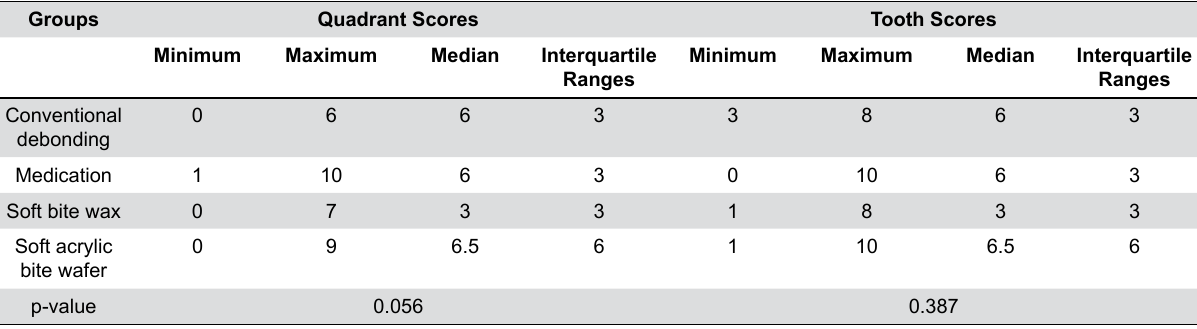
Table 4- Distribution of Numerical Rate Scale (NRS) scores regarding quadrant and teeth in which the patients perceived the highest pain and their between-groups comparisons